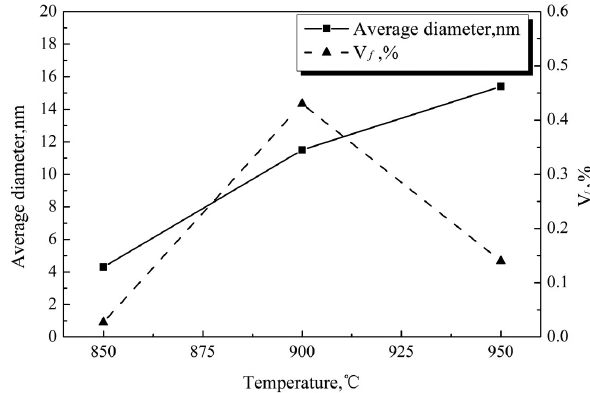
Fig. 11: Average diameter and volume fraction of particles as a function of temperature in Ti-bearing